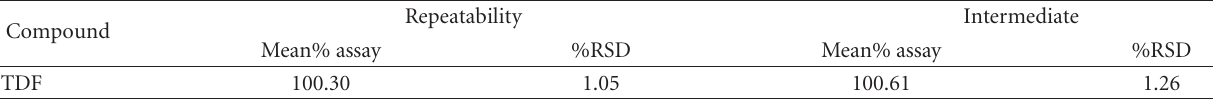
Table 1: Precision of HPTLC method a .